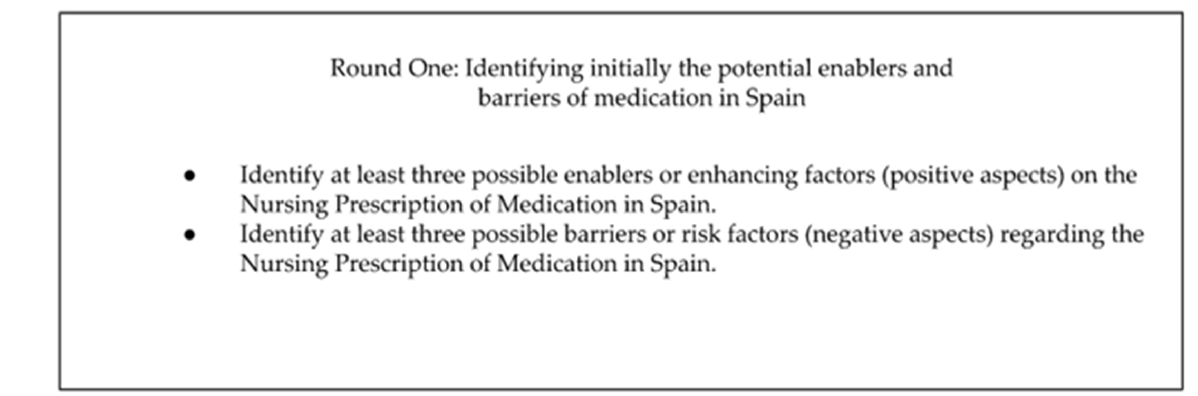
Figure 1. Round One: Identifying initially the potential enablers and barriers of medication in Spain.